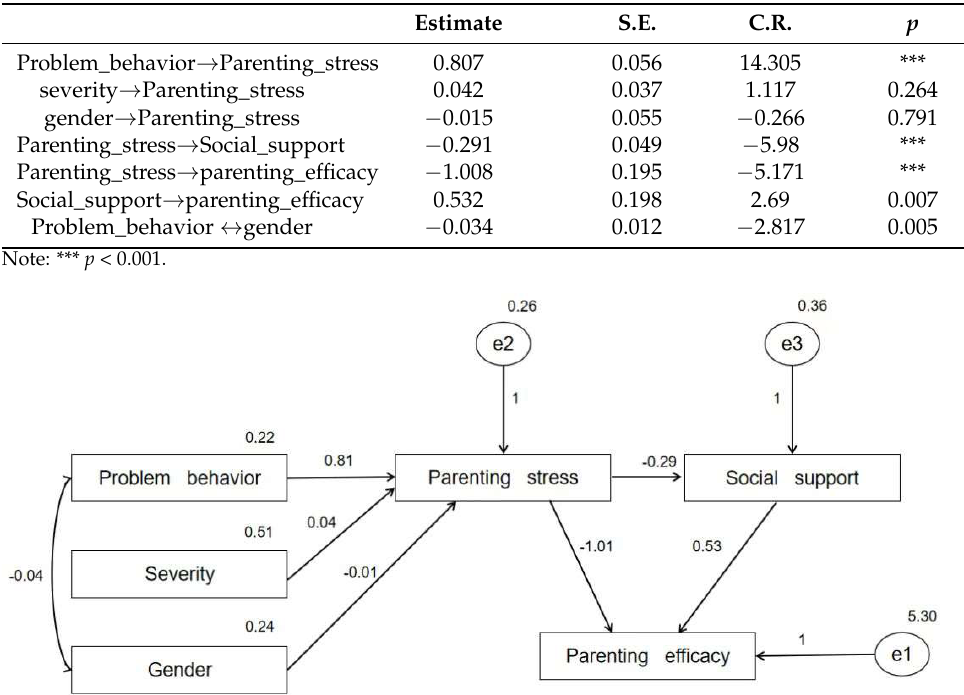
Table 3. The outcome of model fitting.